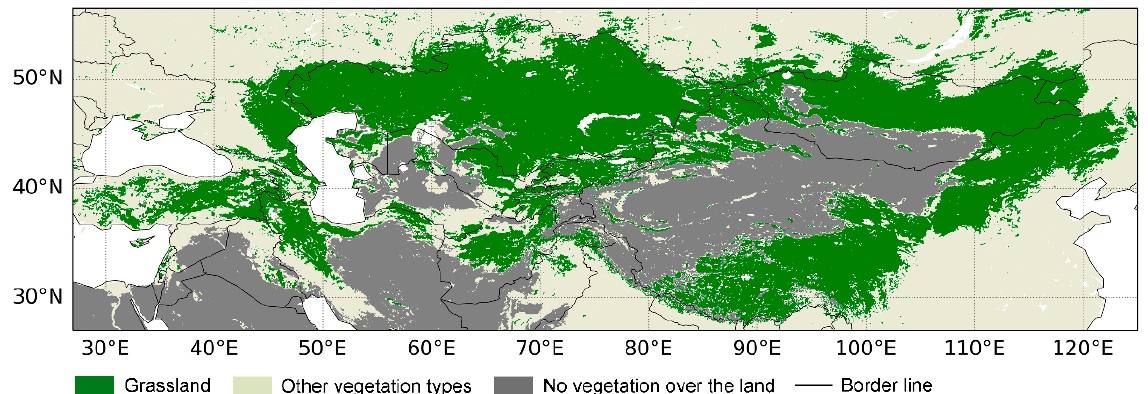
Figure 1. The study area: the Eurasian steppe. The classification followed the International Geosphere-Biosphere Program (IGBP) principle derived from Moderate Resolution Imaging Spectroradiometer (MODIS) land cover product with a 0.05° spatial resolution. Water has been masked by the color white.